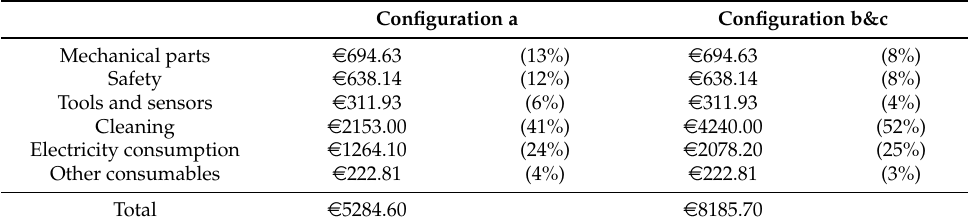
Table 7. Annually recurrent operation and maintenance costs C a , t of the integrated collector.